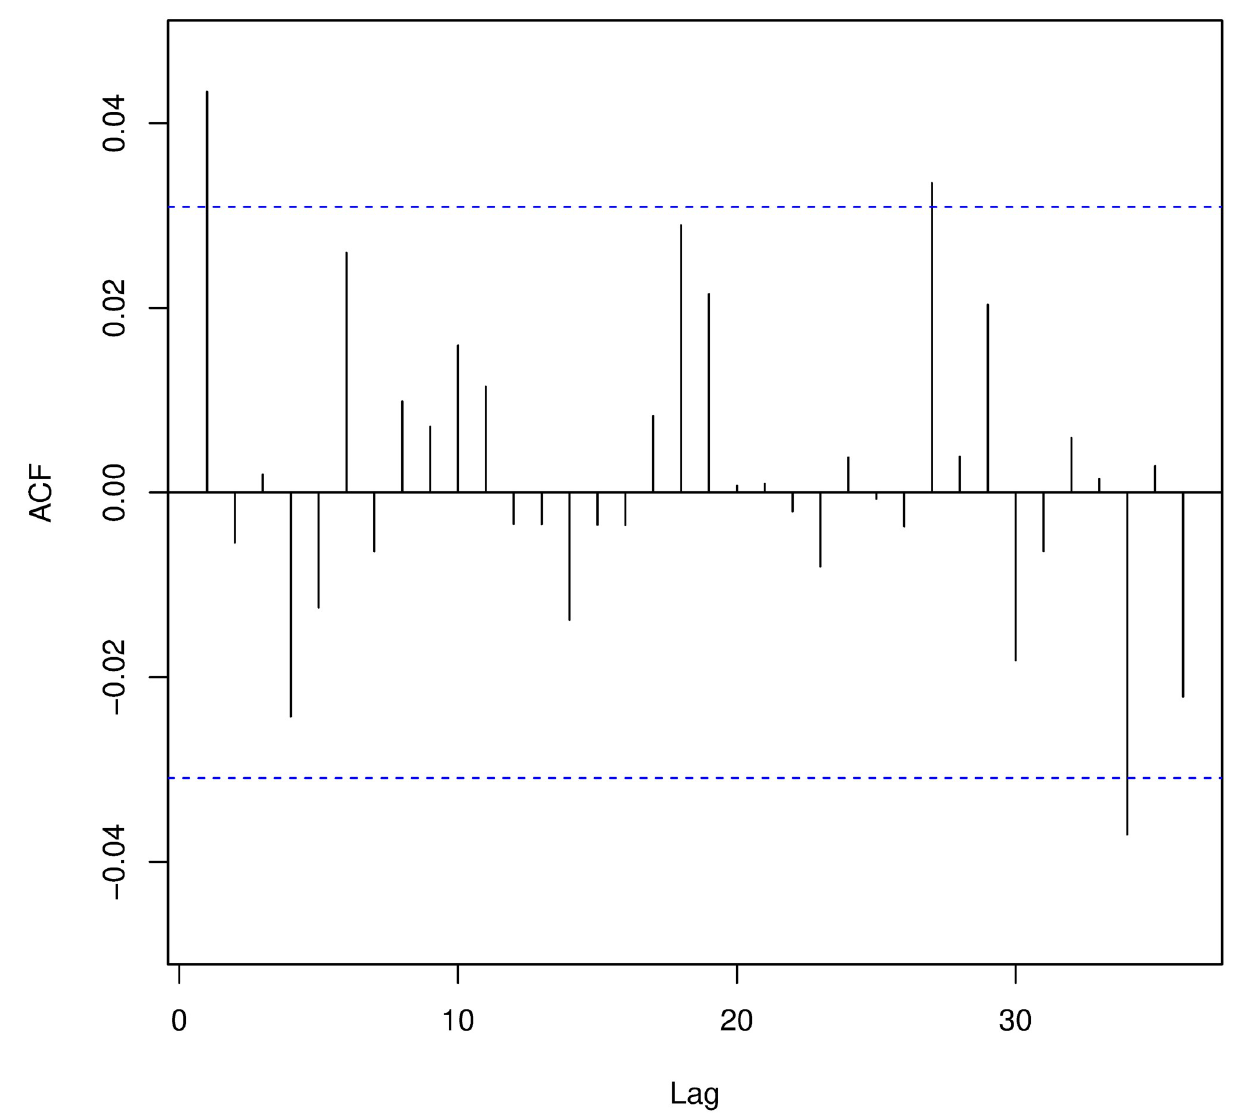
Fig 7. Autocorrelation function of